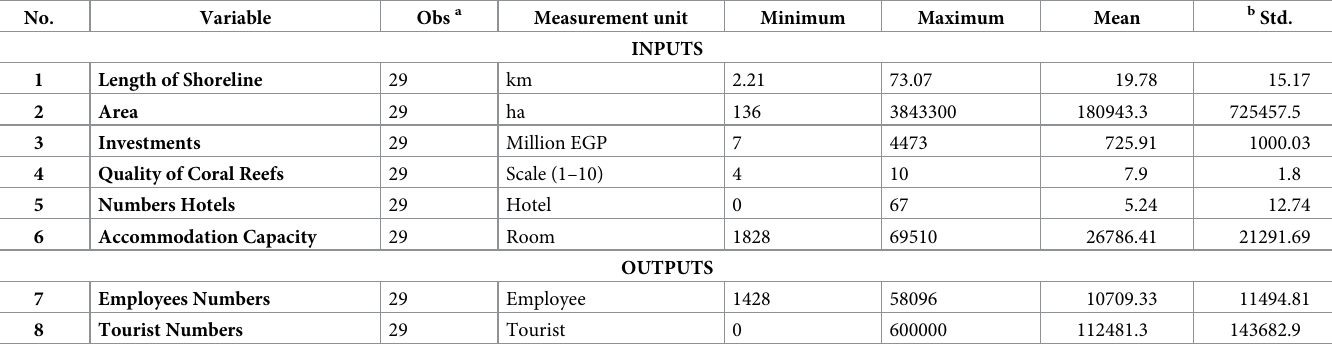
Table 1. Descriptive statistics of coastal tourism centres data (inputs & outputs) of